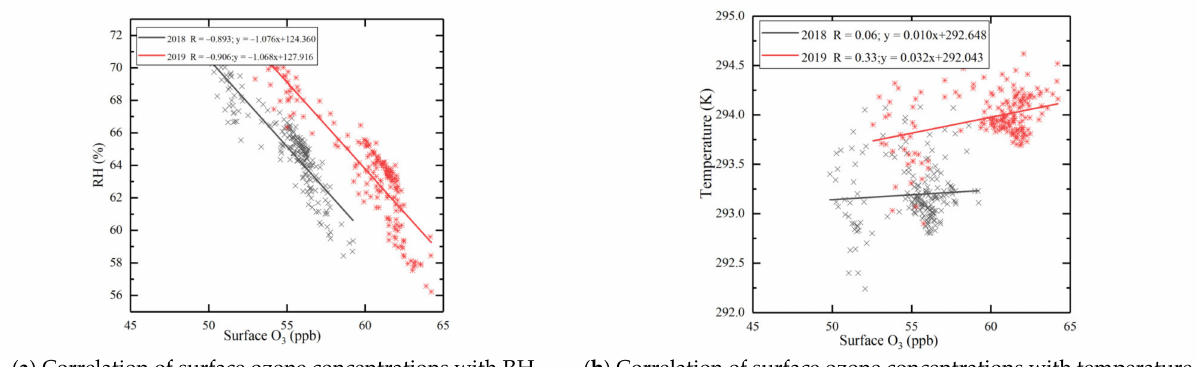
Figure 15. Correlation of surface ozone concentrations with RH ( a ) and temperature ( b ) in eastern Sichuan and western